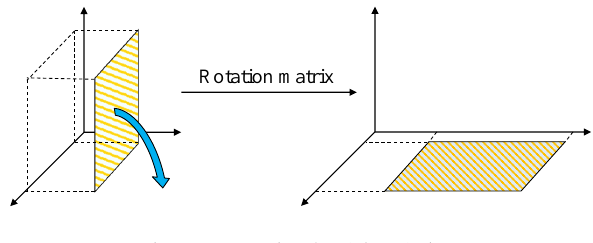
Figure 7. Rotating 3D (planar)